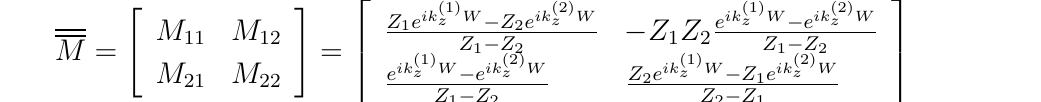
= 1 . 01 , d = 1 . 2 µ m, τ = 10 − 12 s, T = 300 h